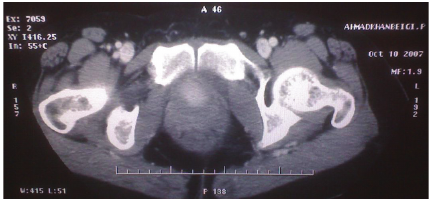
Figure 2: An intravesical mass near bladder neck with hyperdensity in CT scan of patient.